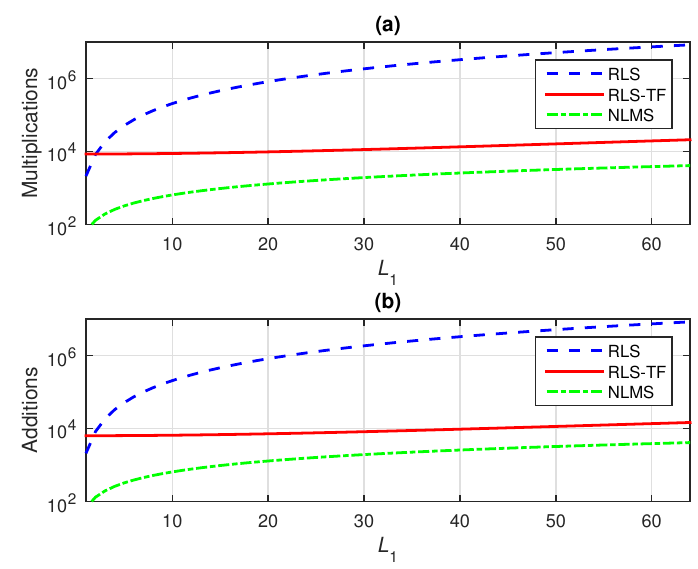
Figure 1. Computational complexity of the proposed RLS-TF algorithm, as compared to the conventional RLS and NLMS algorithms, as a function of L 1 ; the other dimensions are set to L 2 = 8 and L 3 = 4: ( a ) number of multiplications per iteration and ( b ) number of additions per